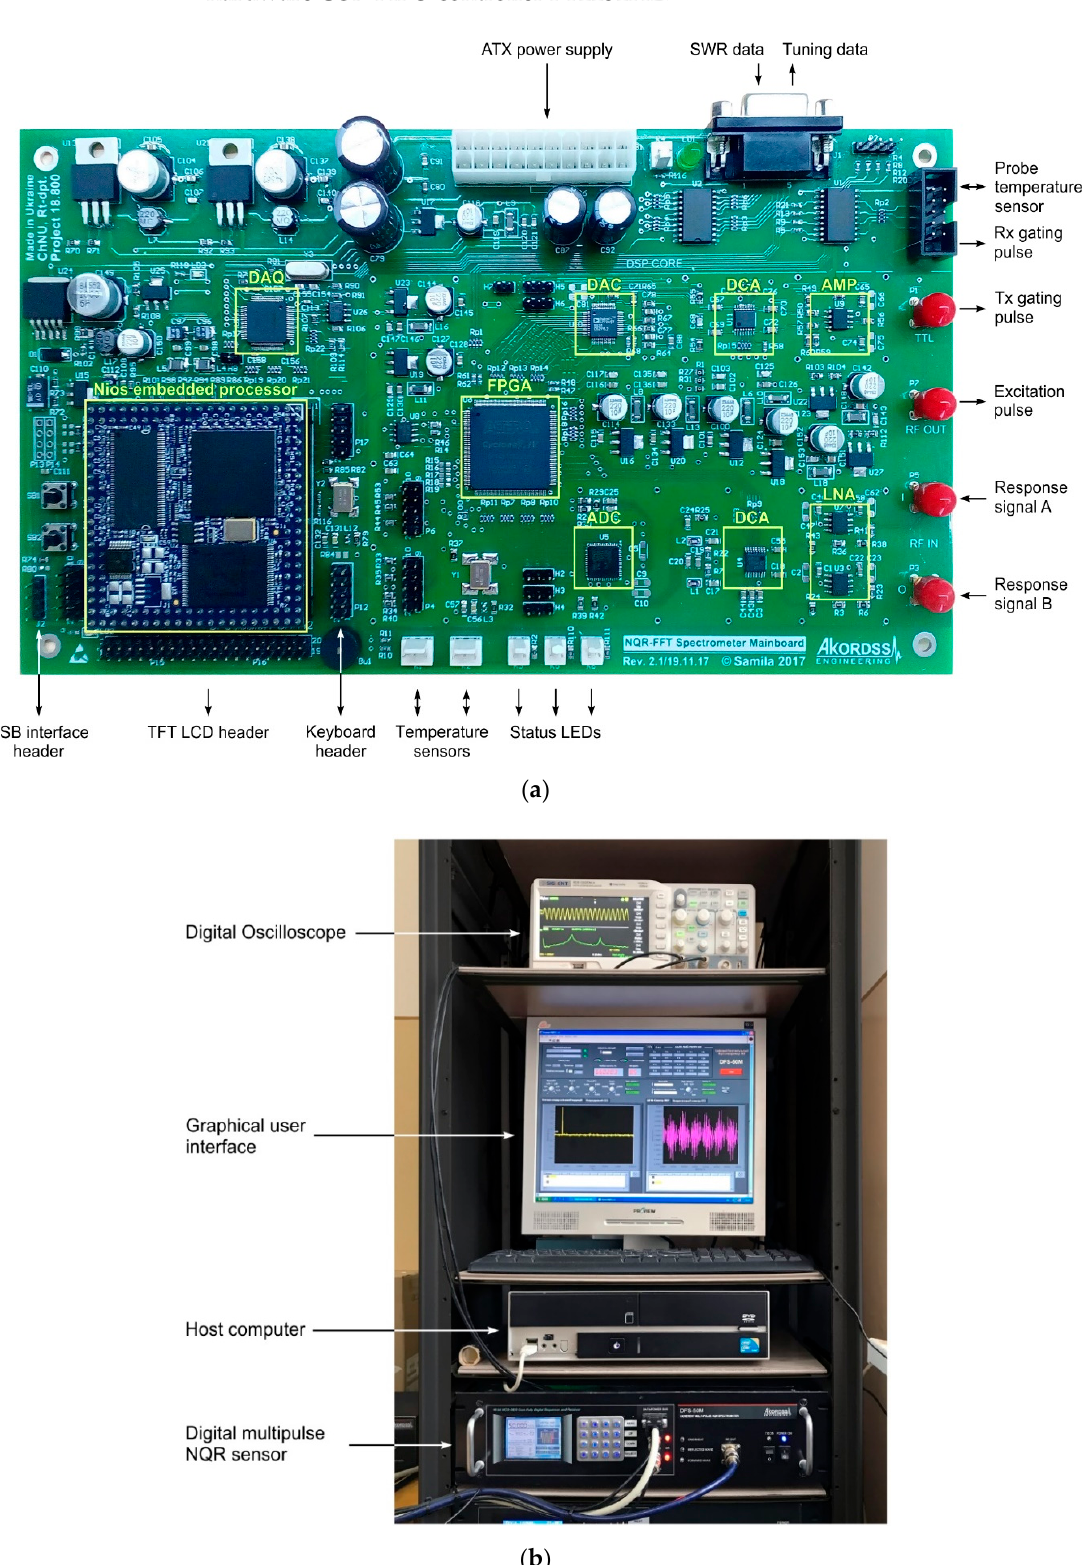
Figure 7. Photo of the experimental setup for the study of the proposed configuration structure of the FPGA: ( a ) view of the NQR sensor motherboard; ( b ) measurement setup for the observation of NQR.